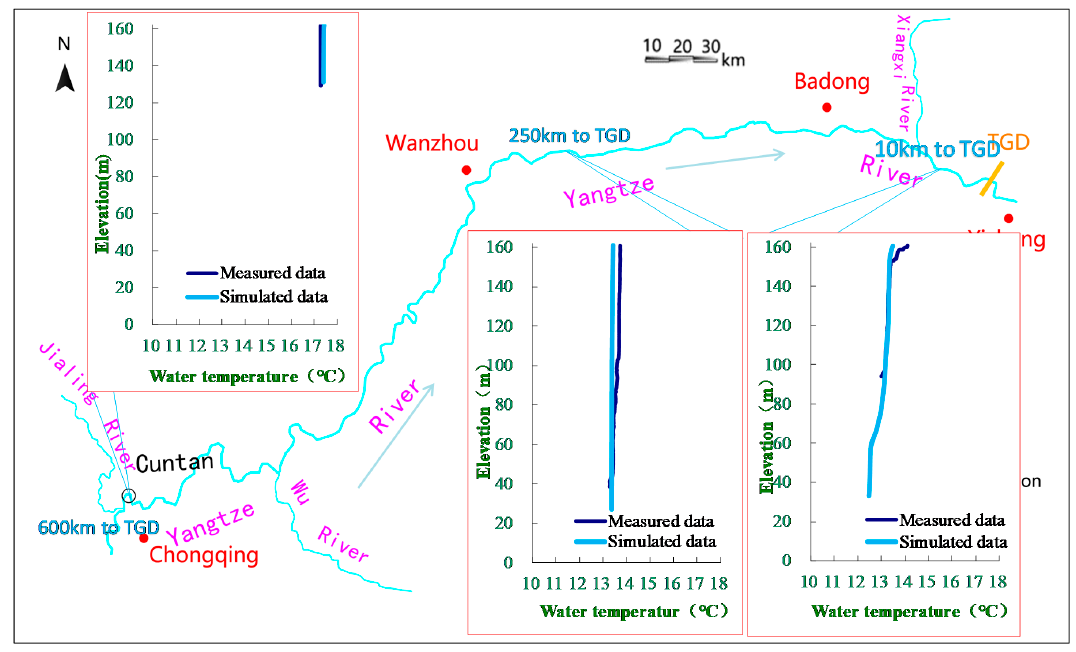
Figure 3. Comparison of simulated and measured water temperatures in the Three Gorges Reservoir on March 28, 2013.